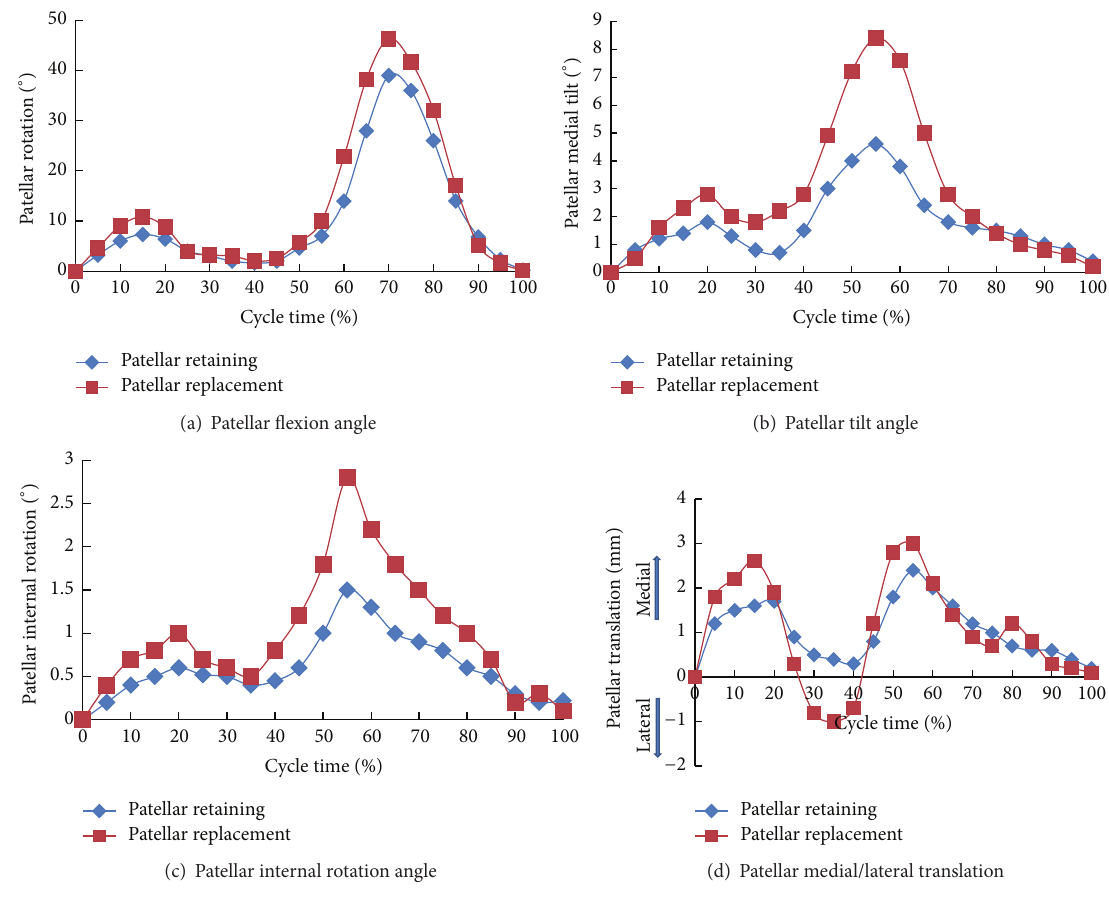
Figure 5: Kinematics of the patellofemoral